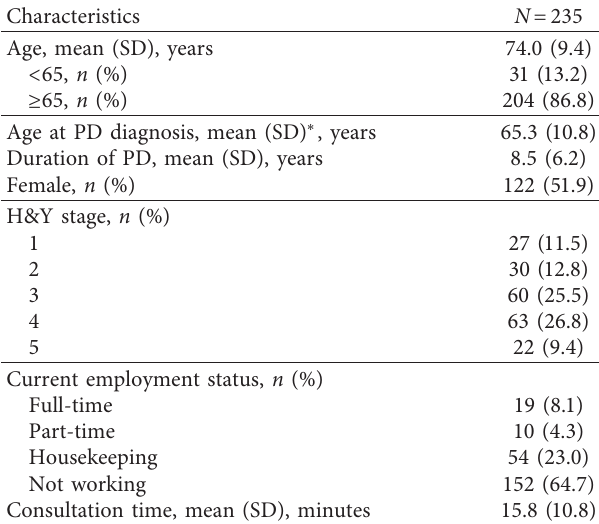
Table 1: Patient demographics and baseline clinical characteristics from patient questionnaires.